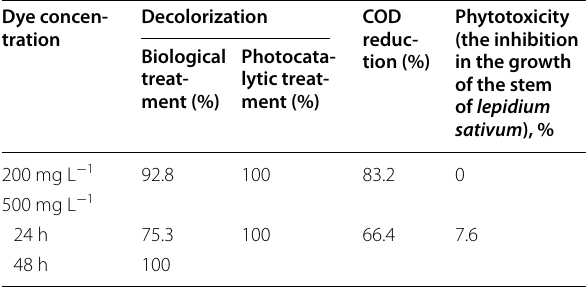
Table 4 Decolorization of Remazol black B, COD ) at different dye con- 2